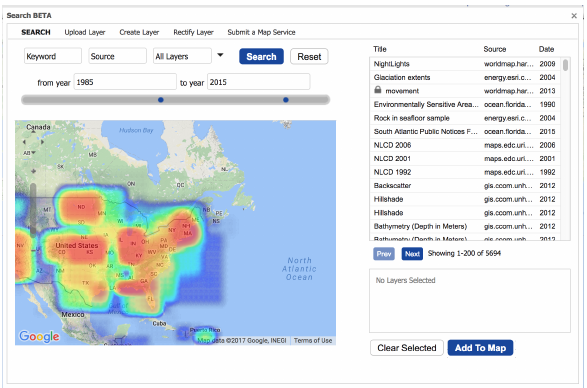
Figure 1. Search using depict-date ranges to discover map layers in an SDI